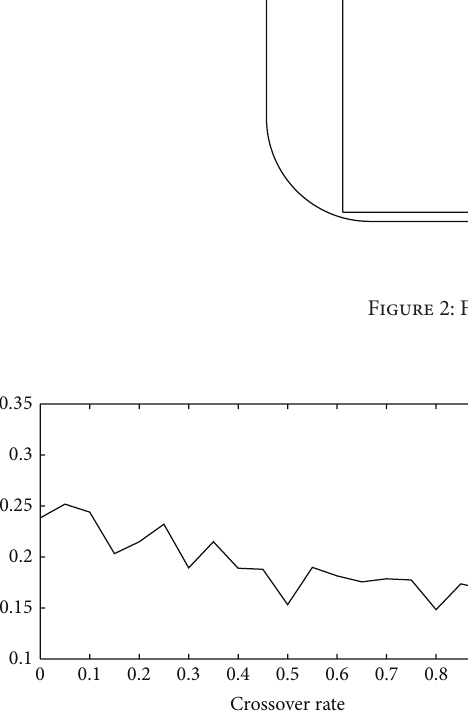
Figure 3: Crossover rate versus